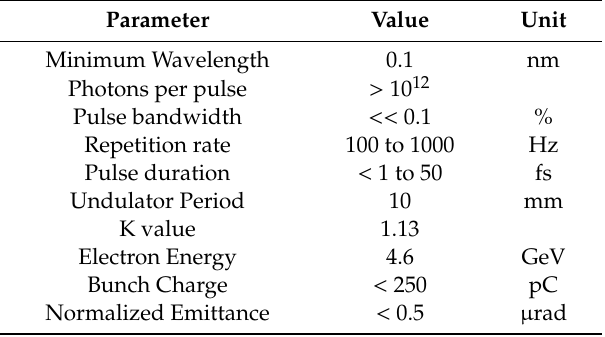
Table 1. CompactLight accelerator